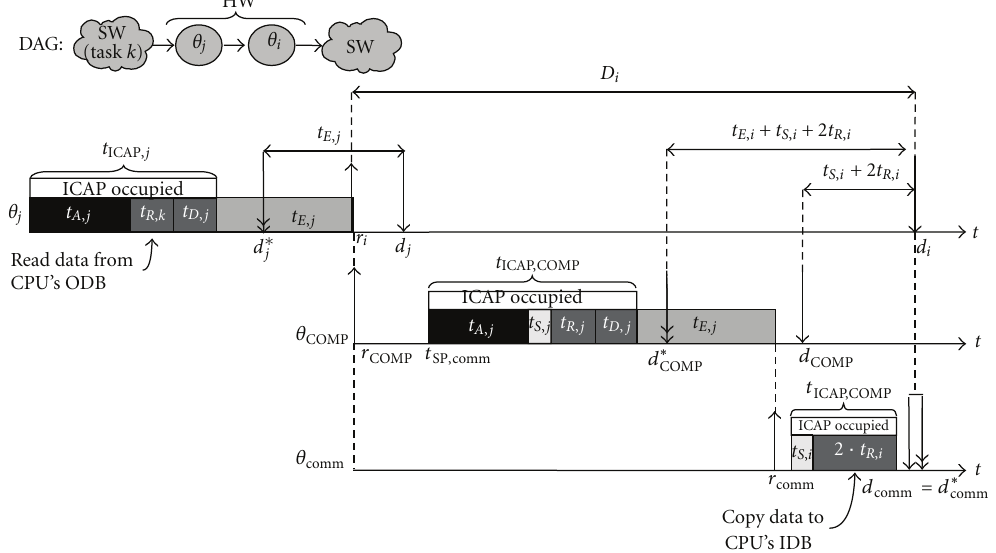
Figure 3: Consecutive execution of hardware tasks in